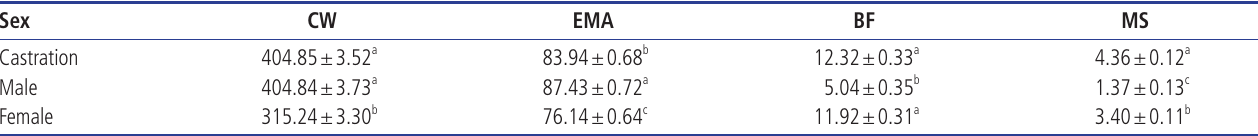
Table 5. Least squares means and standard errors of traits by